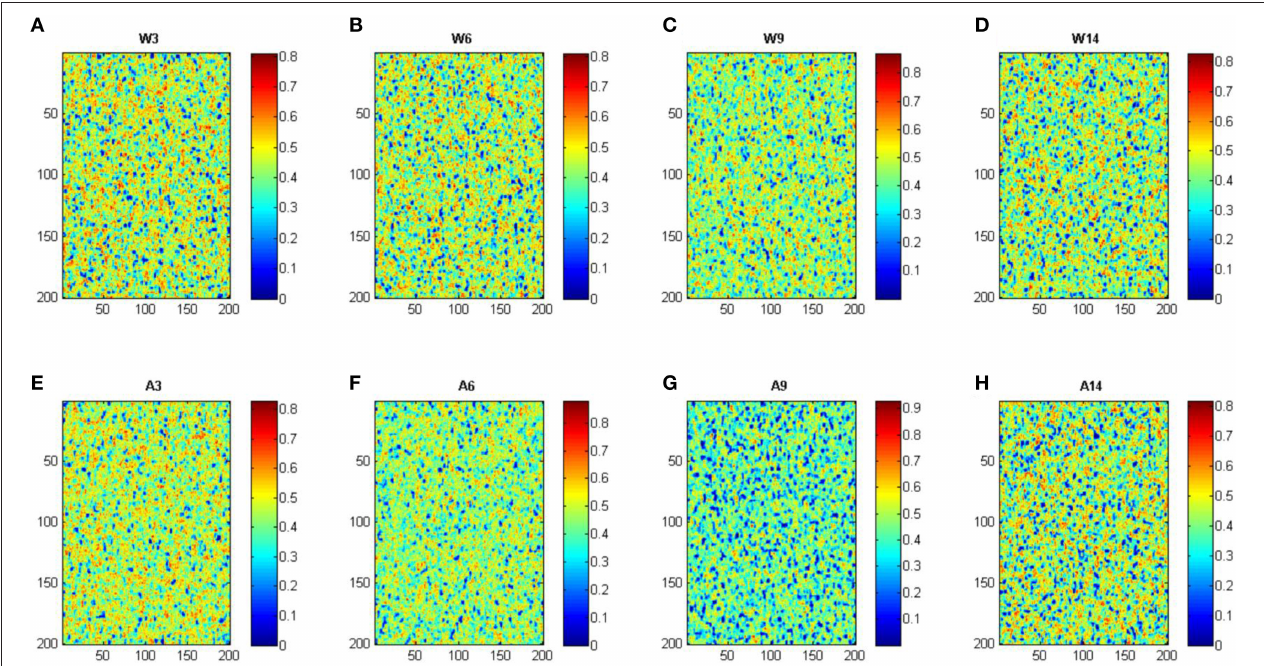
FIGURE 3 | Simulation of cell membrane lipid composition under different conditions. W, Wild-type mice; A, APP/PS1 transgenic mice; ages, 3, 6, 9, and 14 months. Color scale indicates mobility. Panels (A–H) corresponds to conditions: wild-type 3, 6, 9, and 14 months, APP/PS1 3, 6, 9, and 14 months, respectively.